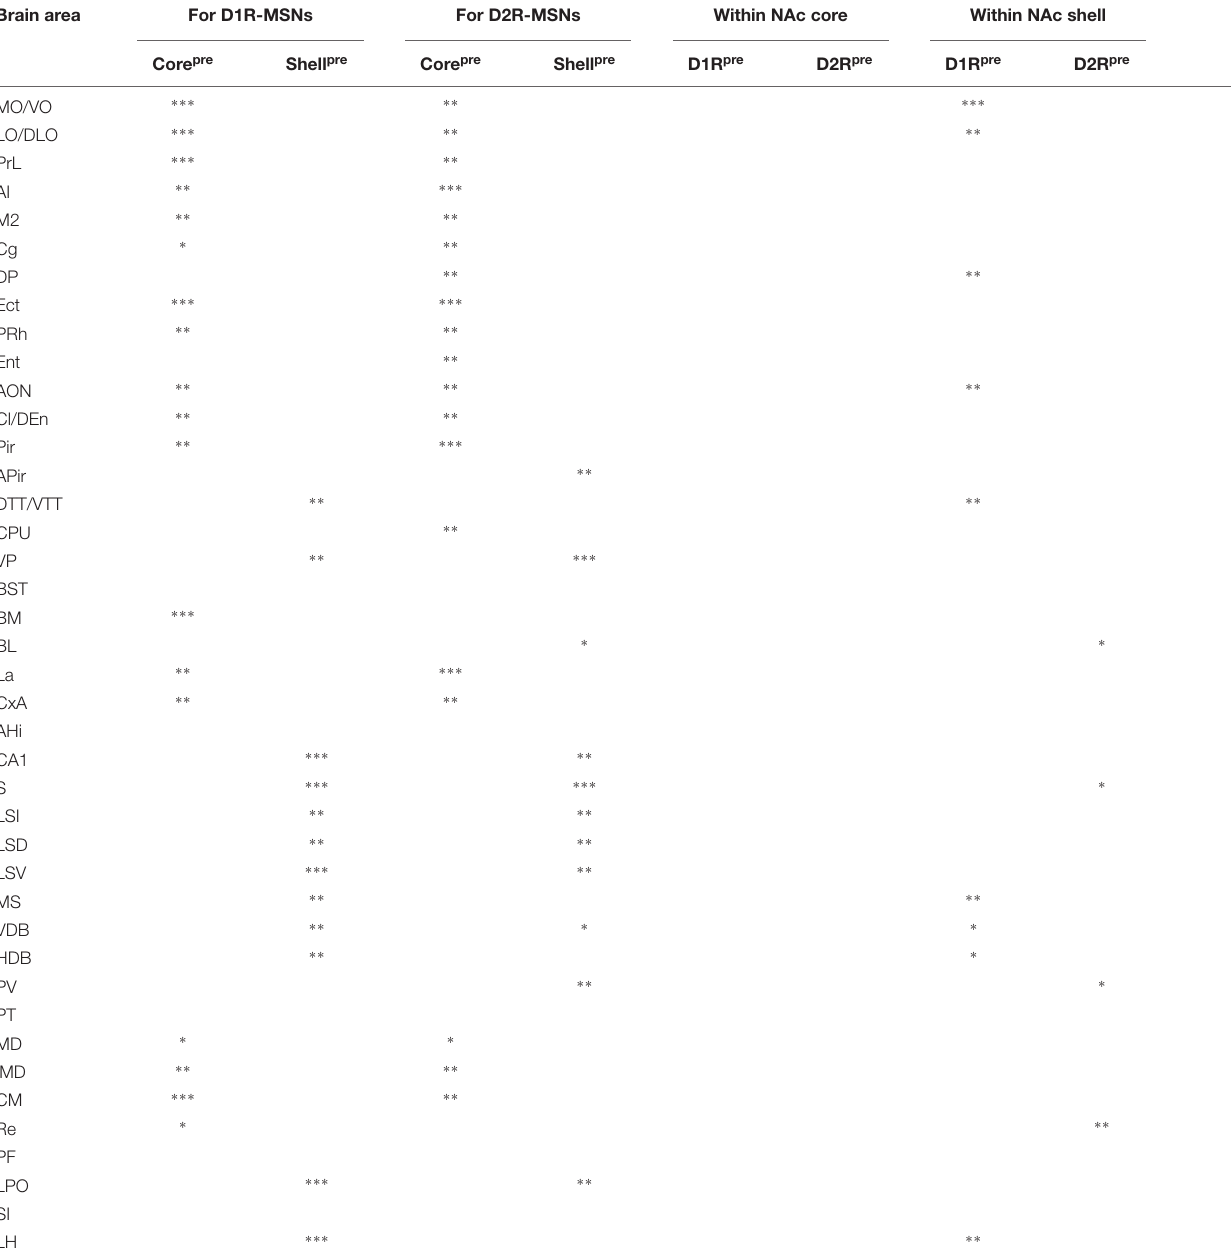
TABLE 1 | Brain areas providing significantly different inputs to each comparison pair. Brain area For